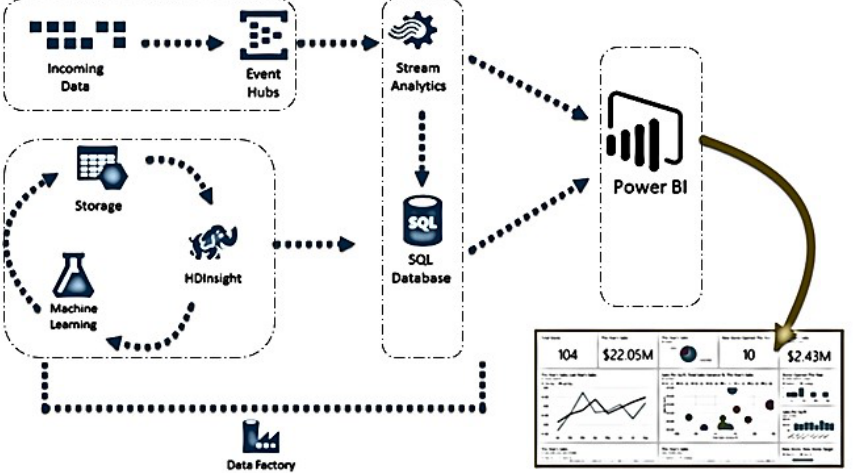
Figure 6. Microsoft Azure working and hub